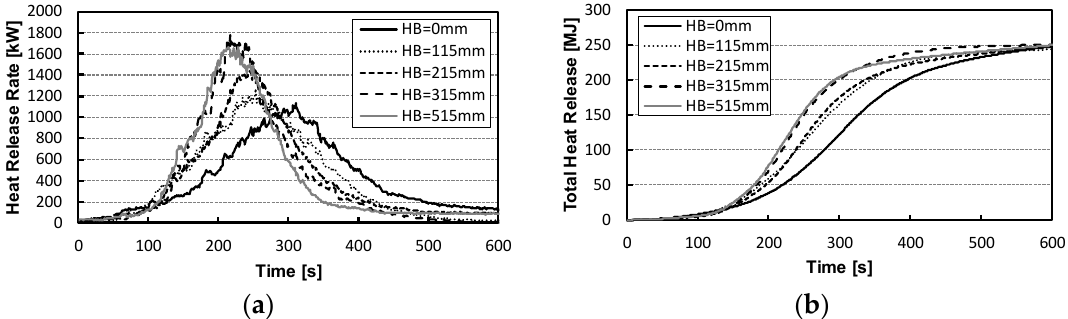
Figure 6. HRRs and THRs of the mattresses under different installation conditions. ( a ) HRR. ( b ) THR.